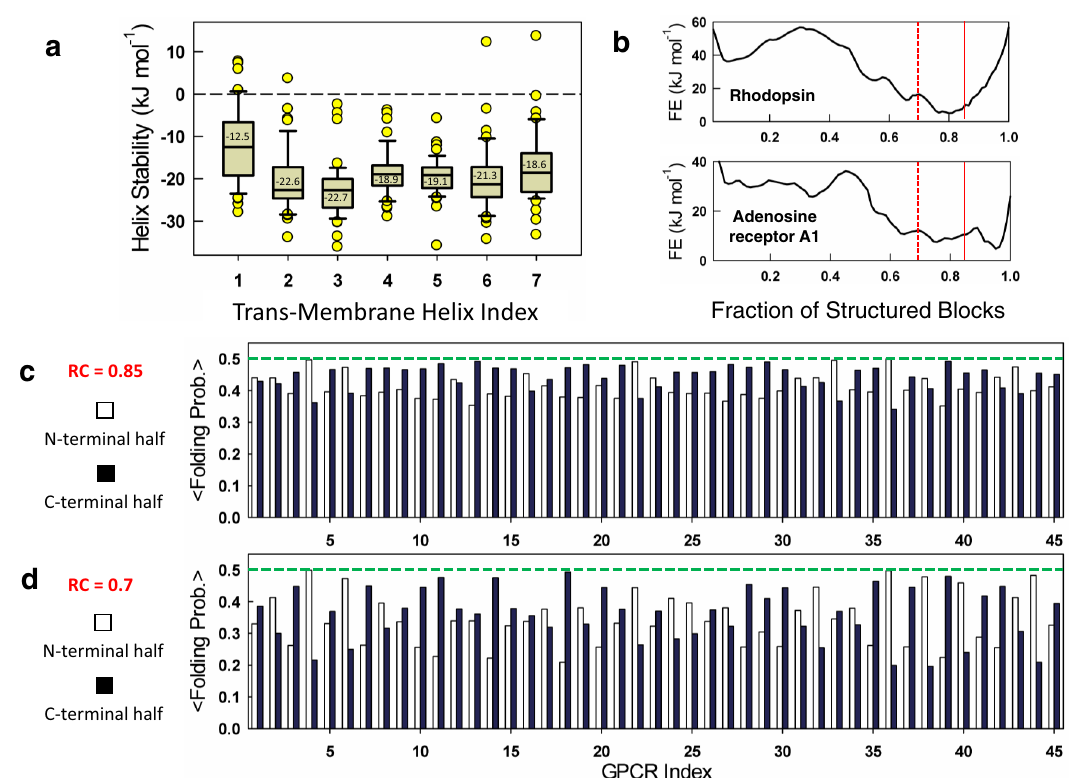
Fig. 2 | Helix stabilities and conformational plasticity at 310K. a Box plot of individual TM helix stabilities ( n =45). Box plots include the median line (median valueindicated),theboxdenotestheinterquartilerange(IQR),whiskersdenotethe rest of the data distribution, and outliers are denoted by points greater than ±1.5×IQR. b One-dimensional free energy pro fi les of two representative GPCRs. The vertical dashed lines signal the reaction coordinate (RC) values of 0.85